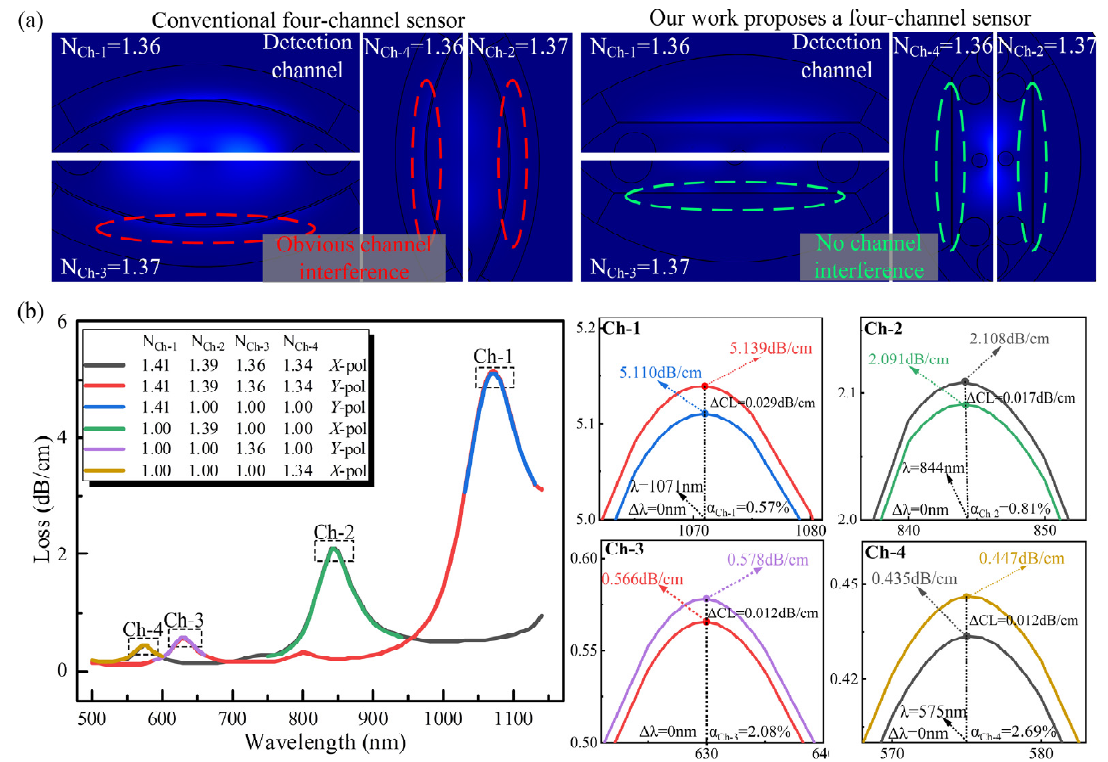
Figure 3. Inter-channel interference analysis. ( a ) Comparison of multi-channel sensing with different structures. ( b ) Multi-channel simultaneous detection and multi-channel separate detection.